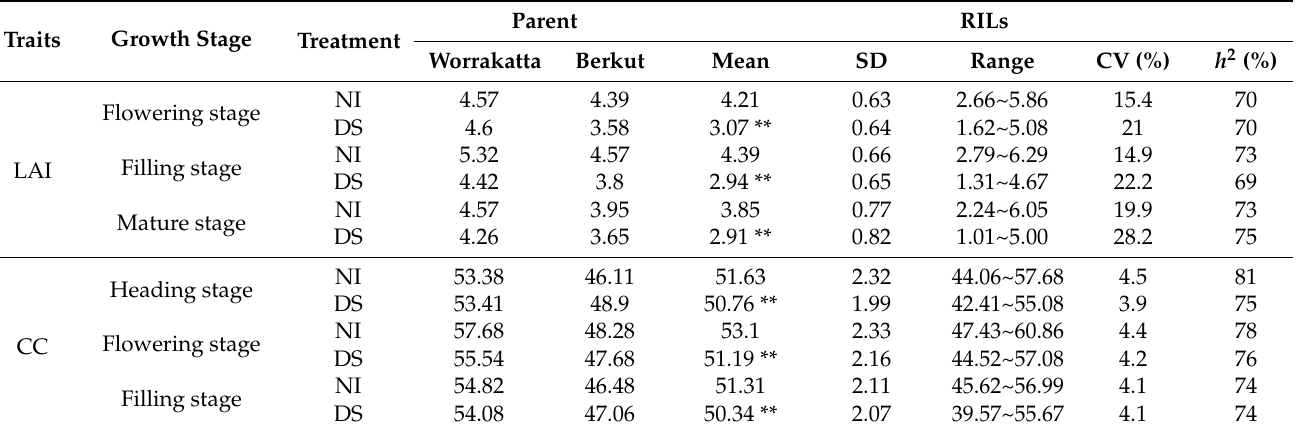
Table 3. Genetic variation of measured LAI and CC of wheat cultivars Worrakatta and Berkut and their progeny recombinant inbreeding lines